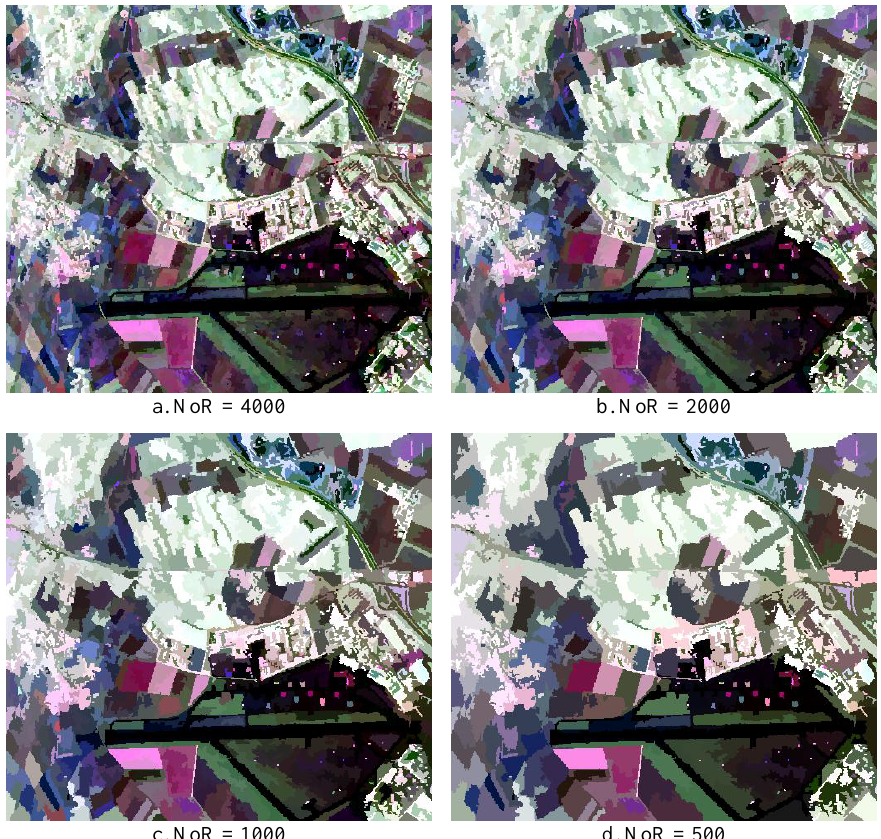
Figrue 8. The GSRM-BPT multiscale segmentation results using the NoR-based pruning